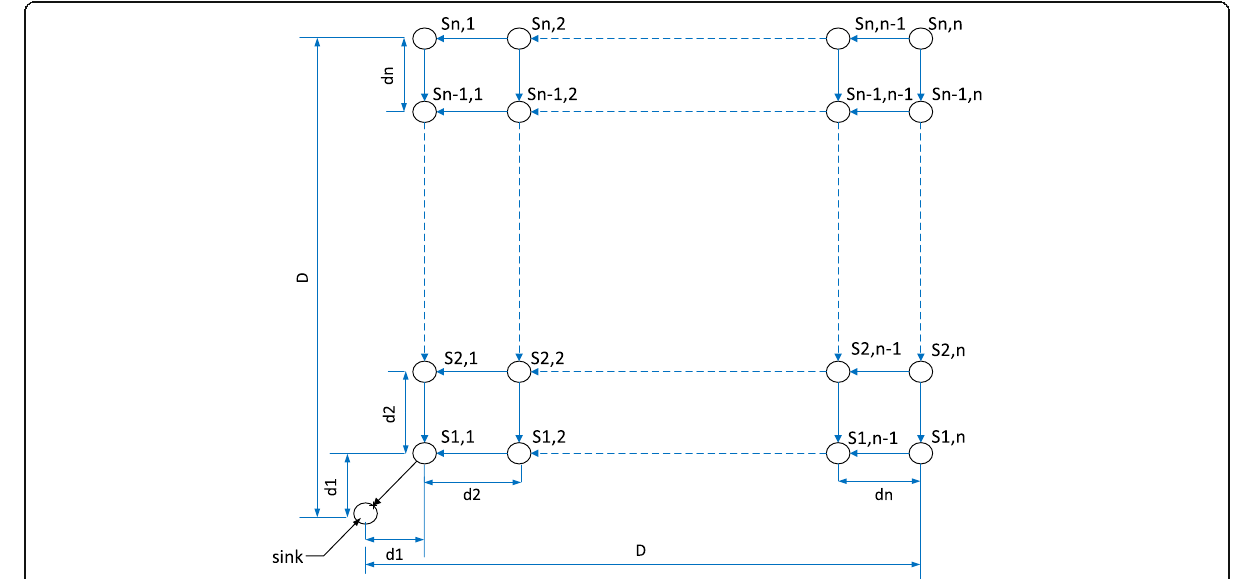
Fig. 6 Illustration of Grid network